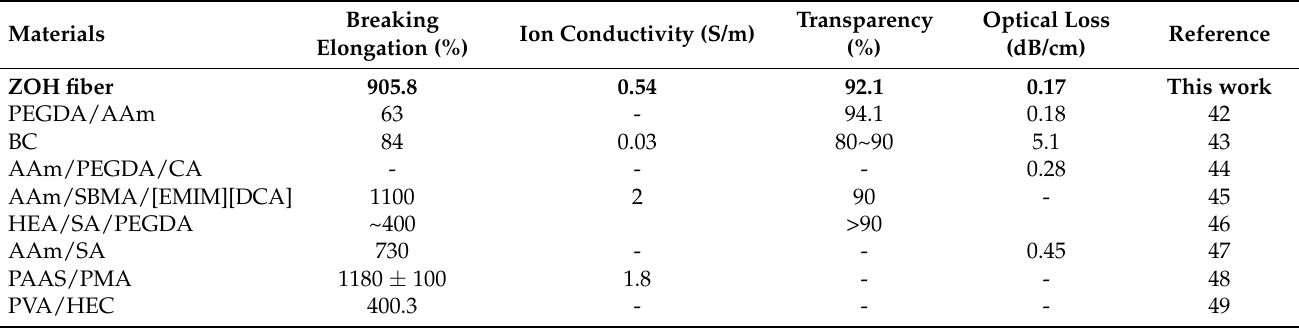
Table 2. Comparison of the ZOH fiber with recently reported gel fibers.